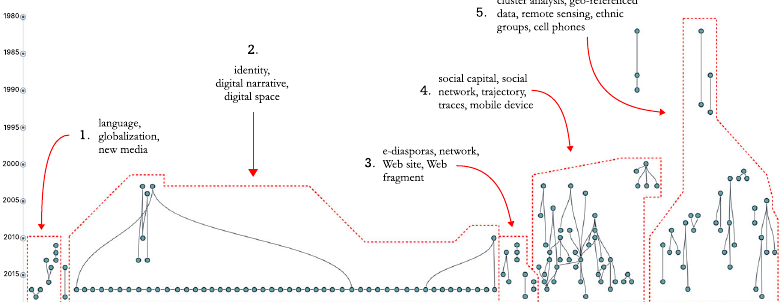
Fig. 2 Phylomemy of 1562 publications related to the digital diasporas and extracted from the Web of Science. Generated by Gargantext and manually